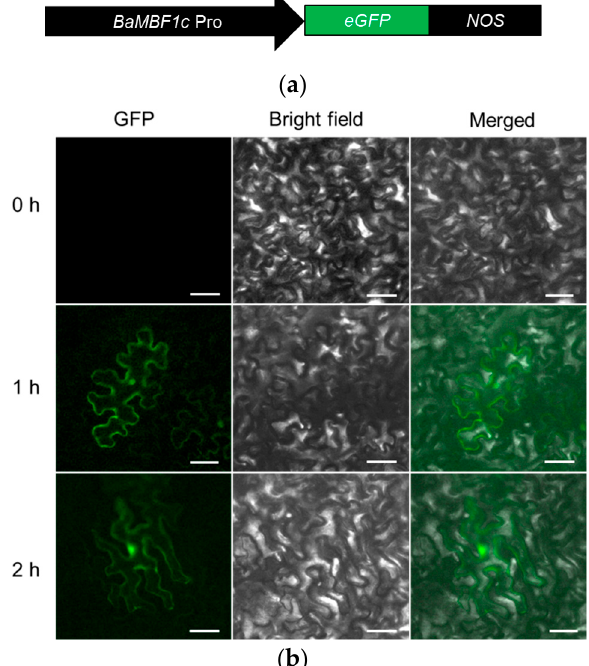
Figure 3. Heat treatment can stimulate BocMBF1c promoter activity. ( a ) Legend of pBI101- pBocMBF1c - GFP construct; BocMBF1c promoter was fused with green fluorescent protein ( GFP ) coding sequence (CDS) with the NOS terminator. ( b ) Treatment at 37 °C induced increased expression in the Nicotiana ( N .) benthamiana leaves after agroinfiltration. Scale bar, 50 μ m.